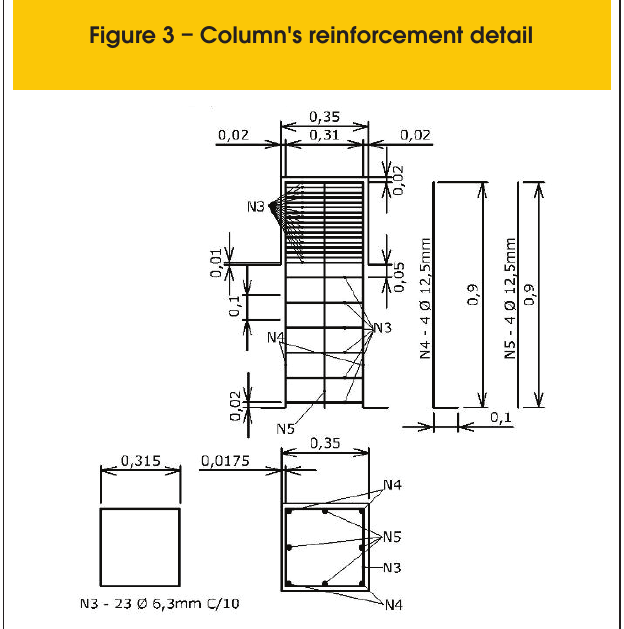
Figure 2 – Piles reinforcement